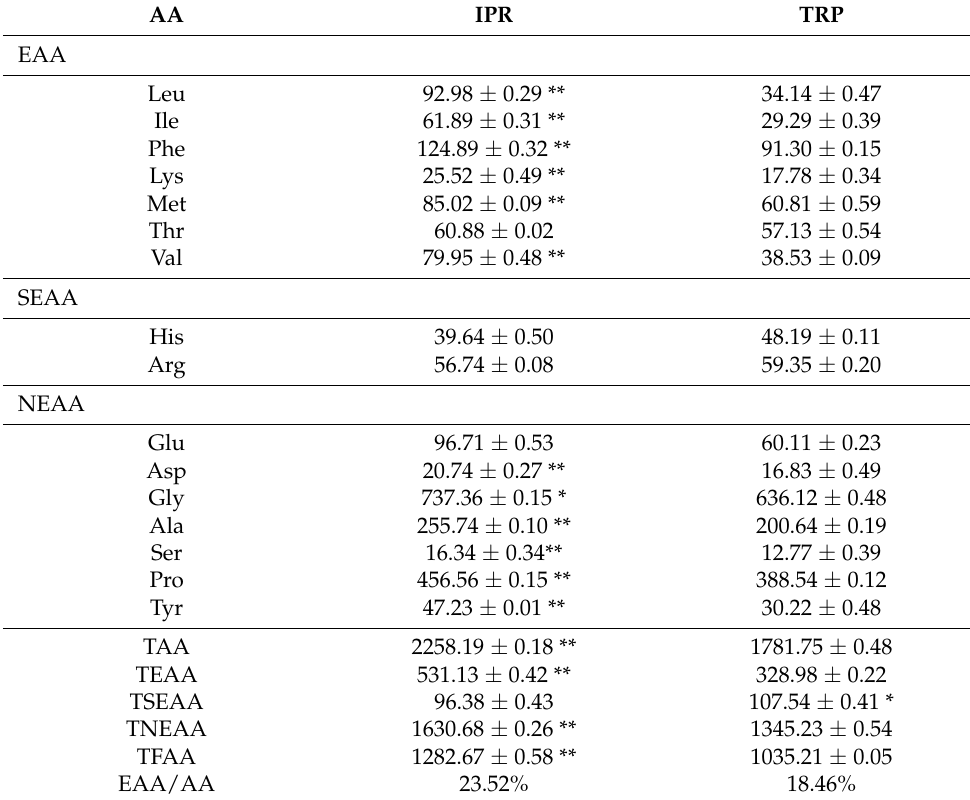
Table 6. Amino acid composition of the muscles of fish cultured in IPR and TRP